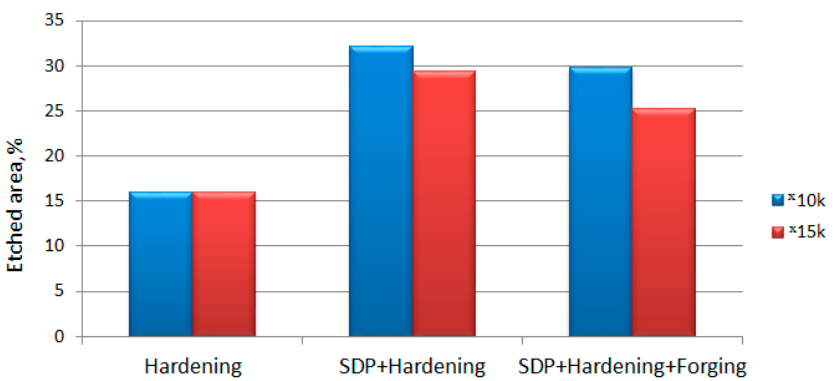
Figure 13. Area of activated and etched material in cross-section of specimens made of W6Mo5Cr4V2 steel (magnification 10,000, magnification 15,000).